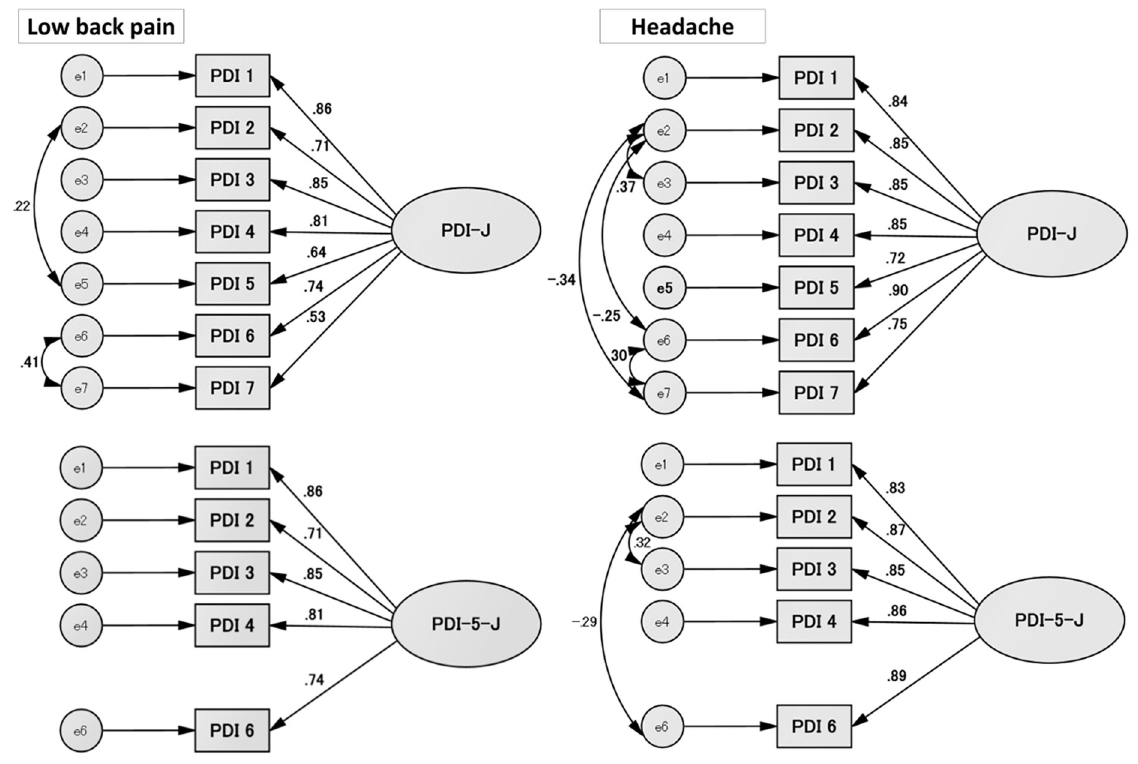
Fig 1. Final path diagrams of one-factor models for the PDI-J and PDI-5-J in chronic low back pain and chronic daily headache. One- factor models of the PDI-J and PDI-5-J with factor loadings and error terms (e1-e7 in PDI-J and e1-e5 in PDI-5-J) are indicated. The left side represents the chronic low back pain, and the right side represents the chronic daily headache. Abbreviation : PDI-J; Japanese version of the Pain Disability Index, PDI-5-J; Japanese version of the 5-item Pain Disability Index.